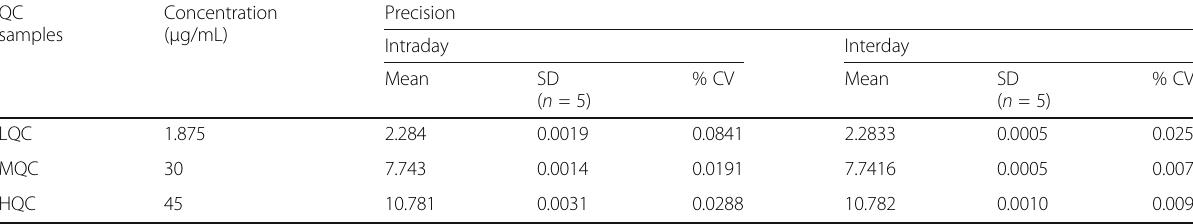
Table 6 Intraday and Interday precision parameters for developed bioanalytical method QC